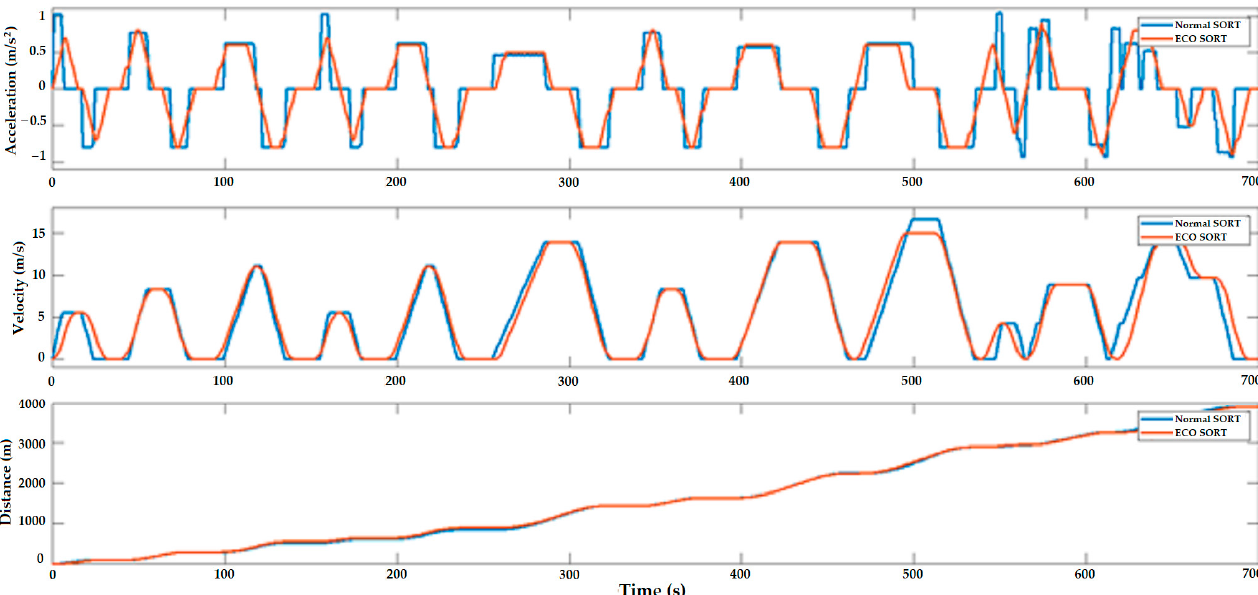
Figure A4. Velocity modification for Eco ‐ friendly profile generated for a standard driving cycle.